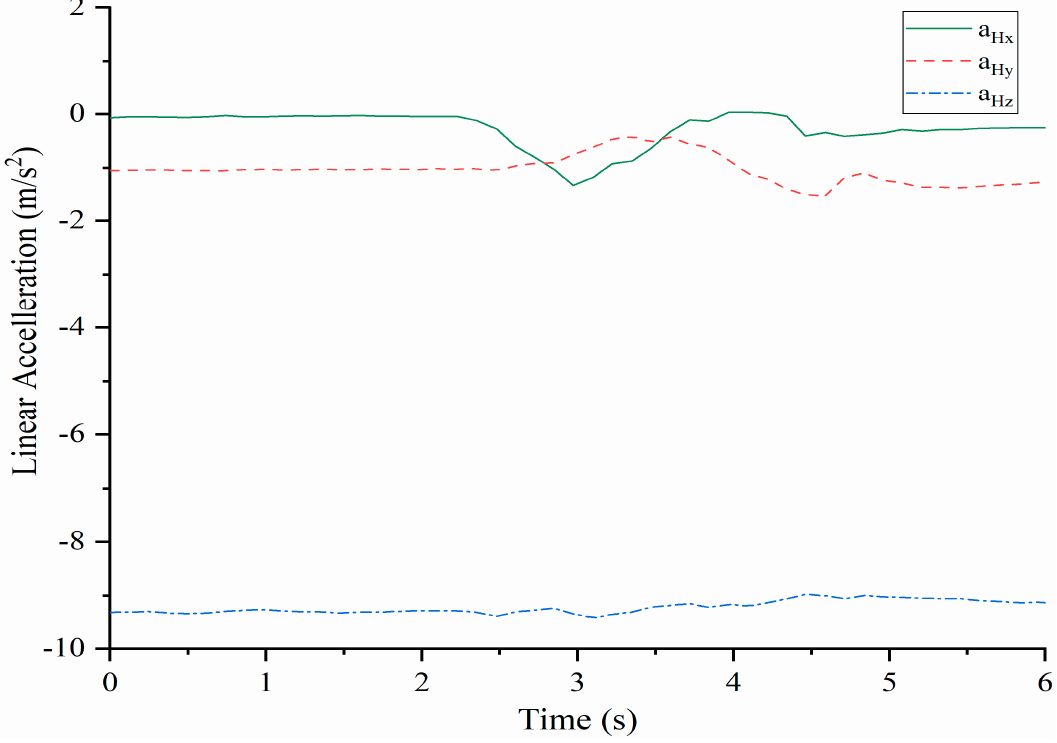
Figure 9. Acquired l inear acceleration of the shoulder point H during full rotation testing, Table 2.